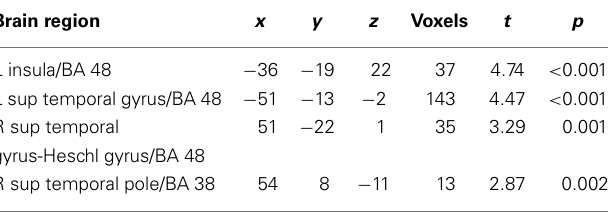
Table 2 | Regions parametrically modulated by Pviv >